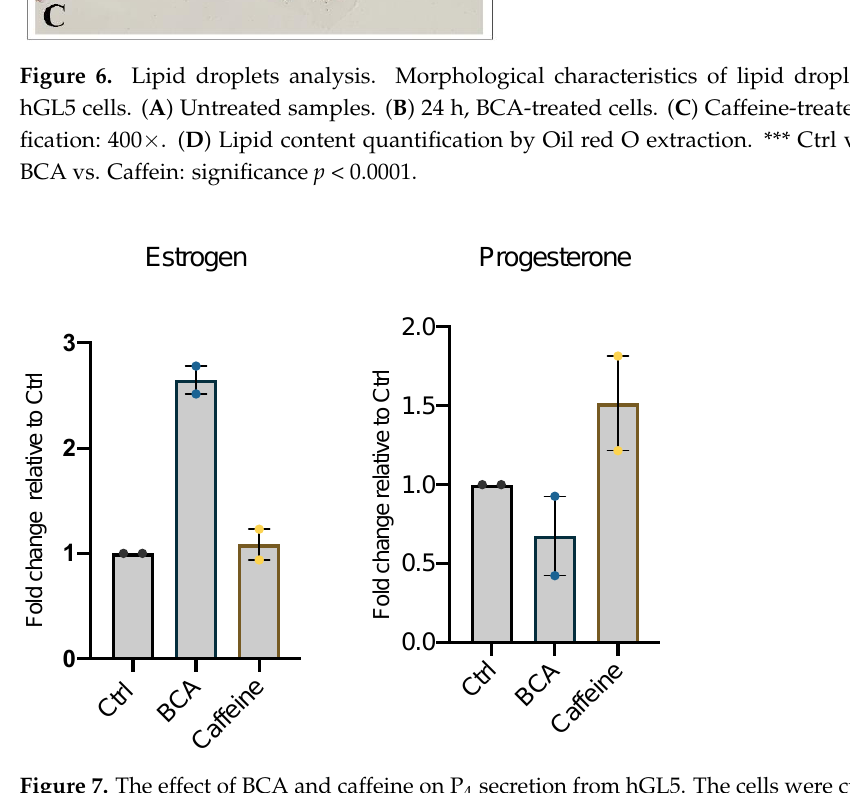
Figure 7. The effect of BCA and caffeine on P 4 secretion from hGL5. The cells were cultured for 24 h with BCA 50 μM or caffeine. Data are expressed as a fold change relative to control culture (set as 1).